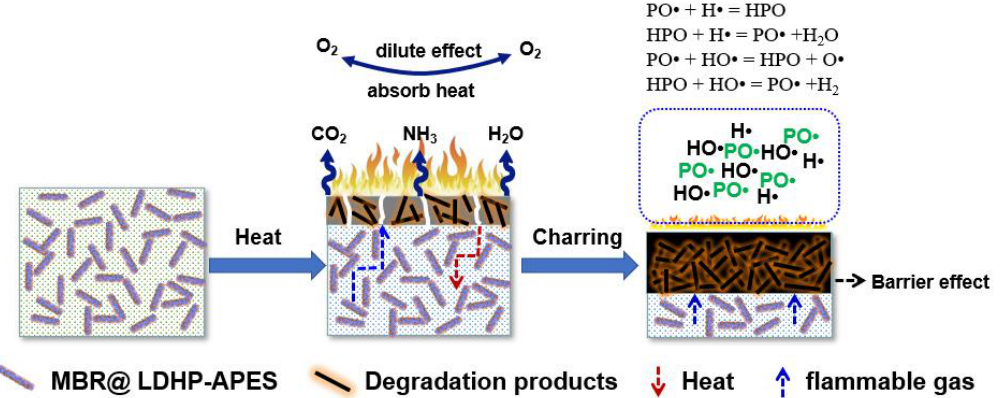
Scheme 2. Depiction of the flame retardant and smoke suppression mechanisms exhibited